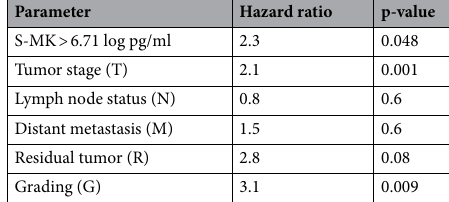
Table 2. Prognostic factors for overall survival in NSCLC. Multivariate analysis of predictive factors for overall survival of NSCLC patients (n = 59). Statistical significance was determined using Cox